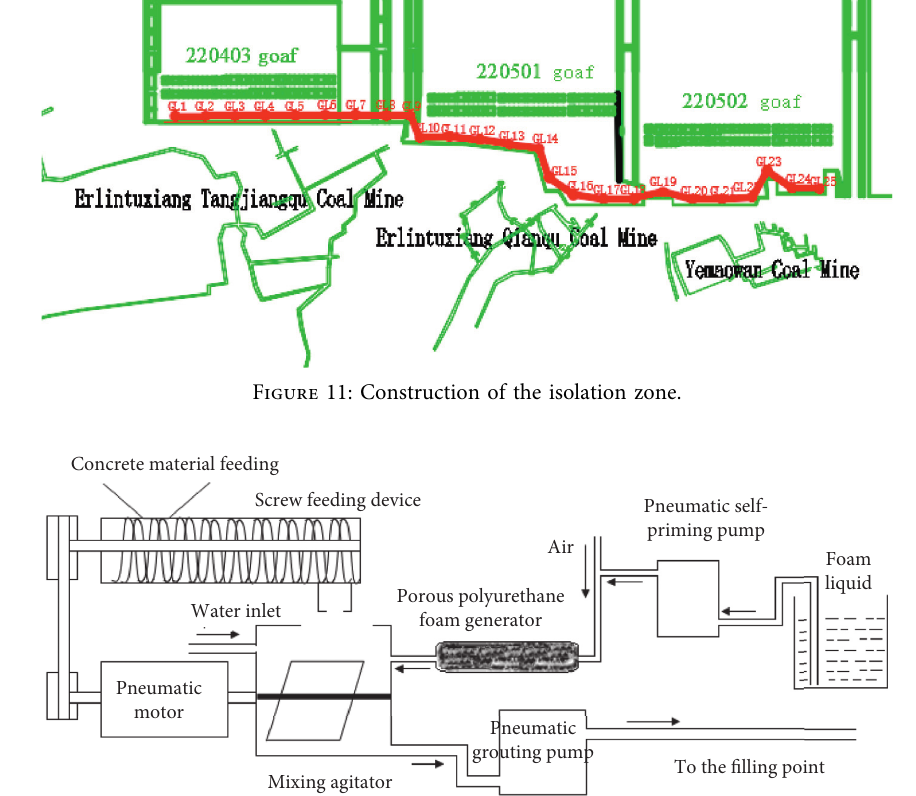
Figure 12: Filling and pouring process of inorganic foaming and